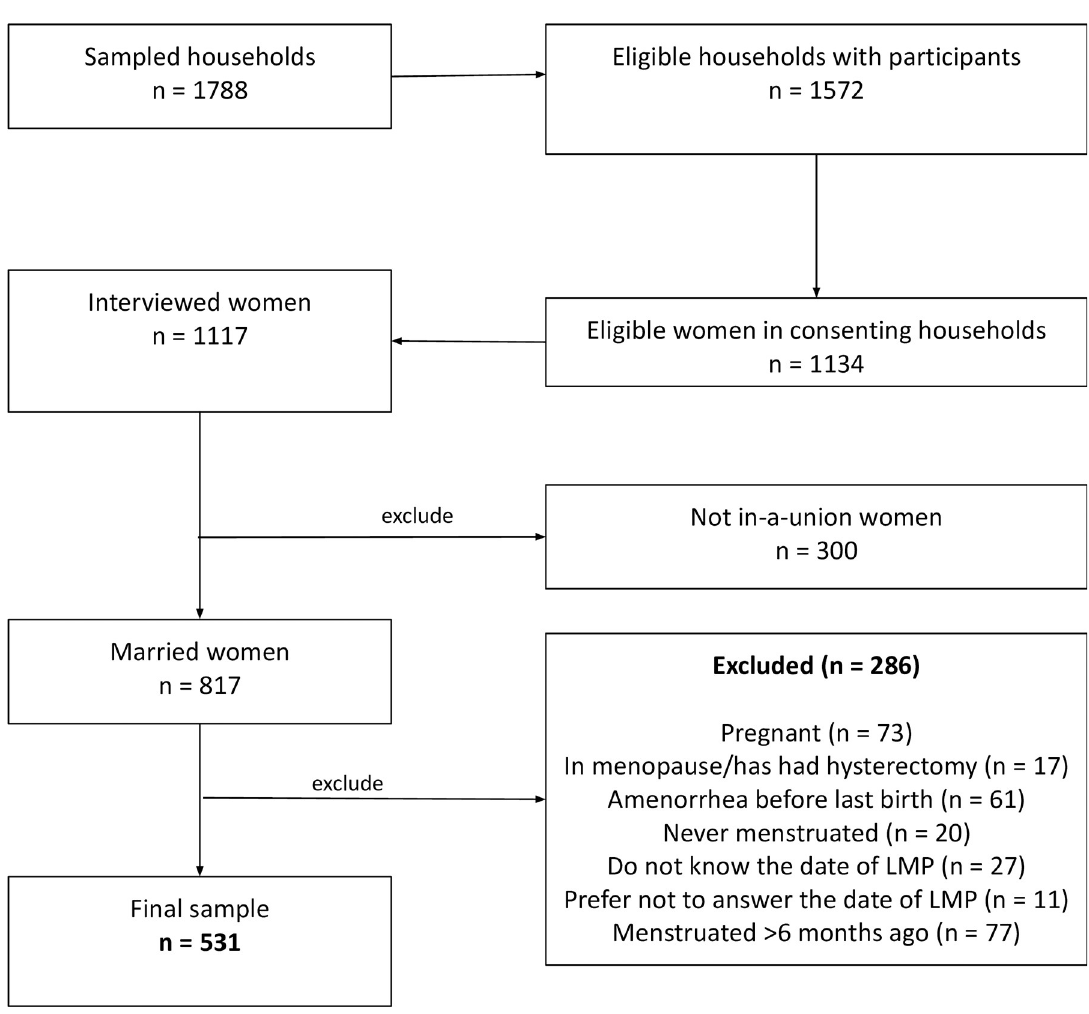
Fig 1. The population of the women aged 15–49 years included and excluded in the endline